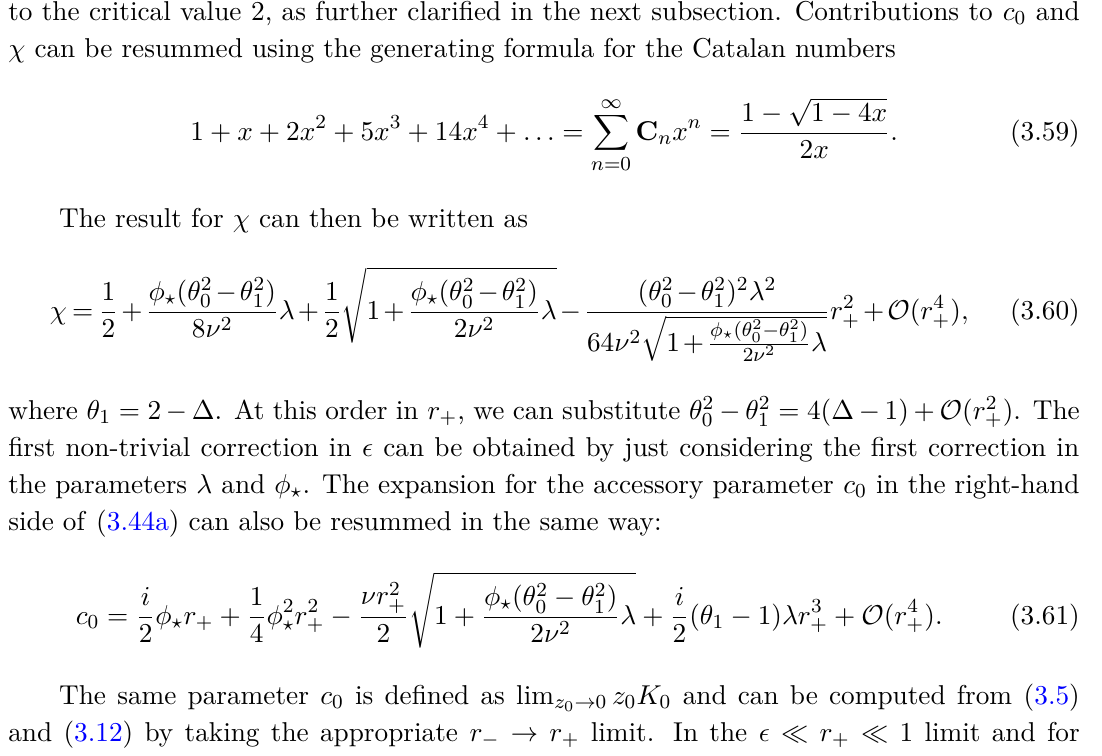
Figure 2 . The fundamental QNM frequency ω 1 , 0 , 0 , 0 as a function of the outer horizon temperature T + for a Kerr-AdS 5 black hole with fixed r + = 0 . 03 and α 2 has the effect of increasing both the real and imaginary parts of the frequency, up to the maximal value 2 π ( T + ) max ’ 8 . 7 , corresponding to r − = 0 , or (cid:15) = 1 / 2 in